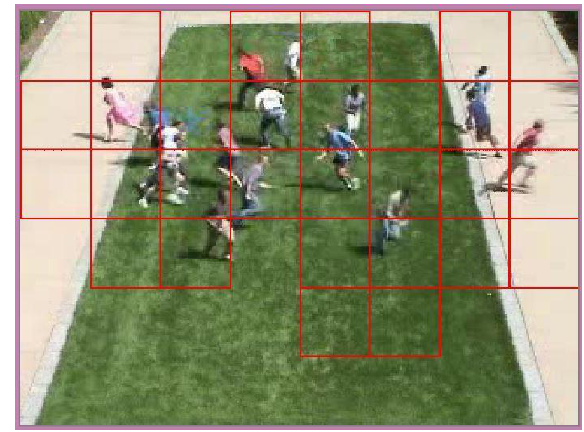
Figure 4. Abnormal Behavior is Table 2. CONFUSION MATRIX OF THE PROPOSED